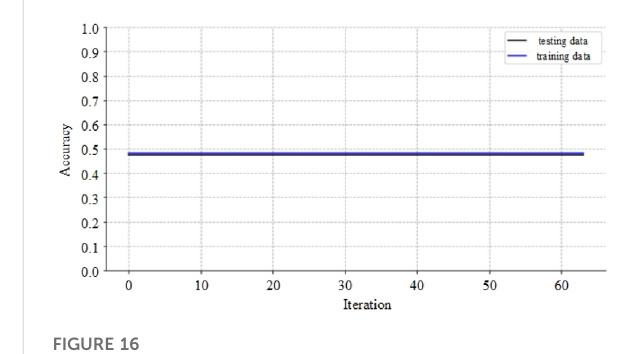
FIGURE 16 Accuracy of LSTM dropout